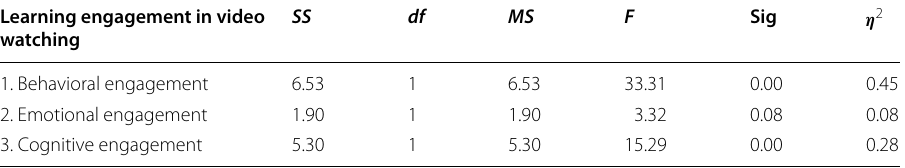
Table 3 Univariate effects for learning engagement in video watching Learning engagement in video